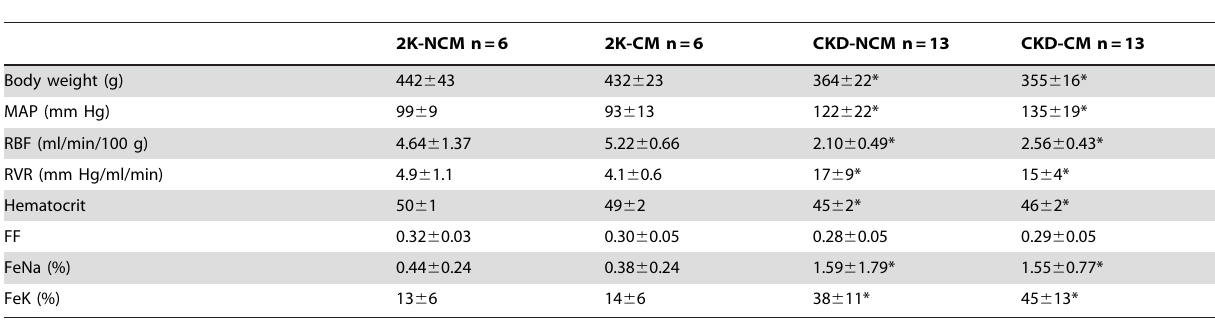
Table 1. Terminal kidney function measurements.